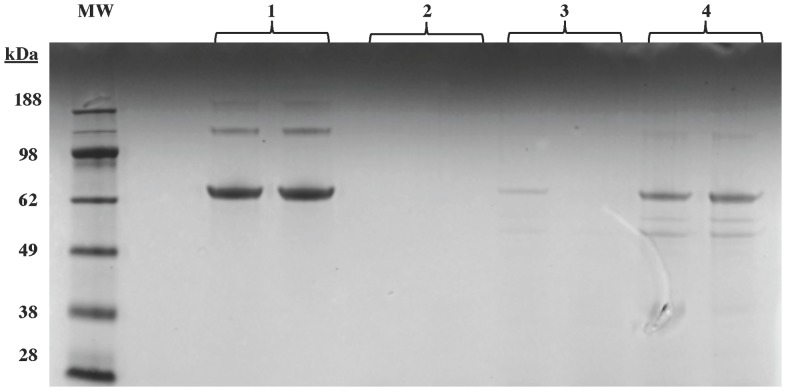
Comparison of S-BEL and FKGK18 Effects on Alpha-Chymotrypsin Activity.BSA (2µg) was digested with trypsin (T) + α-chymotrypsin (C) (final concentration of each <100nM) in the absence and presence of S-BEL and FKGK18 (20µM) for 15min at 37°C. The peptide digests were dried down to 20µl and loaded onto 4–12% Bis-Tris gel and peptide fragments were separated for 35min at 200V constant and visualized by overnight colloidal blue staining. Duplicate Lanes 1, S-BEL + FKGK18; 2, T + C; 3, T + C + FKGK18; and 4, T + C + S-BEL.